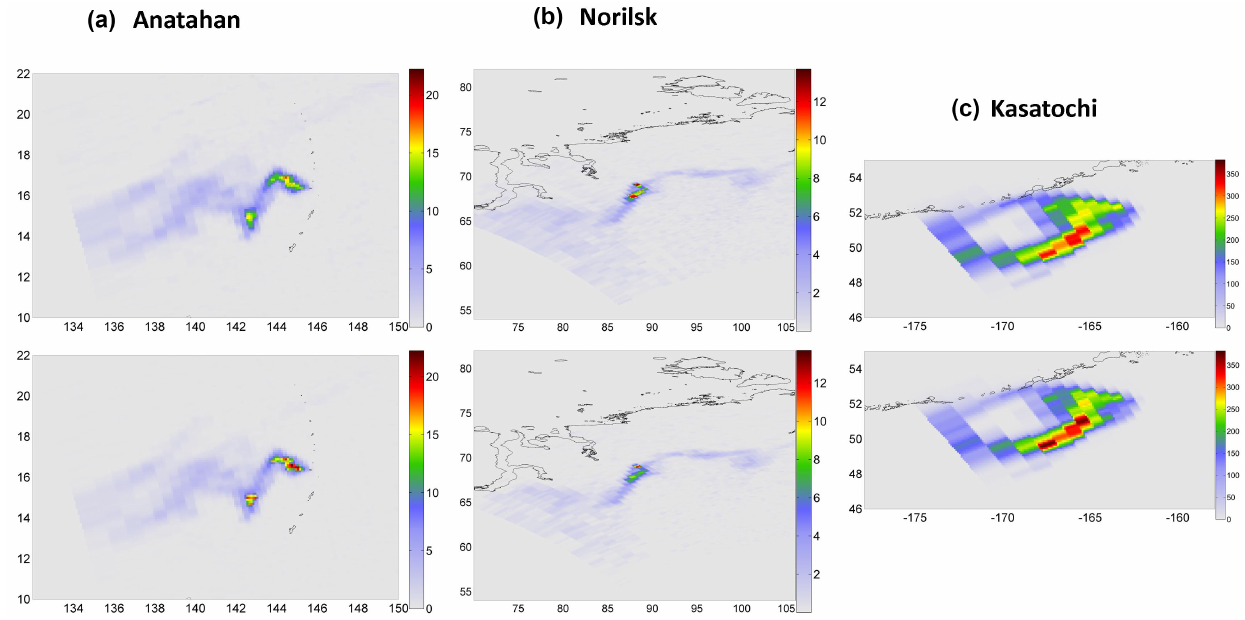
Figure 9. OMI SO 2 VCD (expressed inDU) for the verification (upper panels) and prototype algorithms (lower panels) for the three selected scenarios: during the Anatahan eruption (left), over the Norilsk copper smelter area (center) and for the volcanic eruption of Kasatochi (right). Note that, for each case, the color bar has been scaled to the maximum SO 2 VCD from both